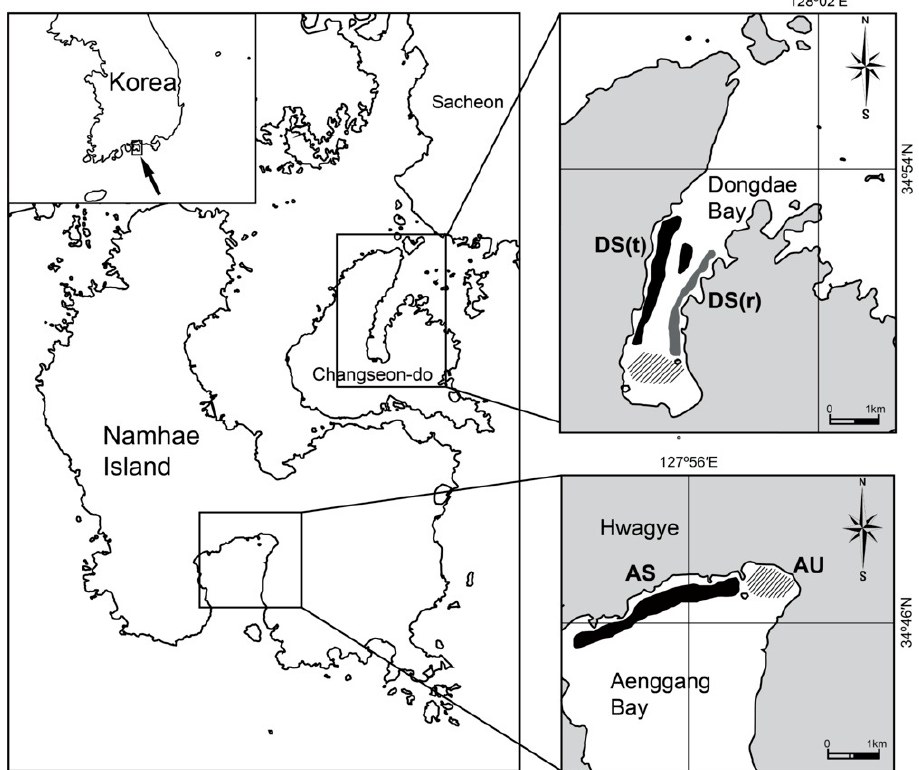
Figure 1. Namhae Island, South Korea, area of investigation. Black area = seagrass bed adjacent tidal flat (DS(t), AS), gray area = seagrass bed adjacent rocky shore (DS(r)), oblique area = unvegetated site (AU).